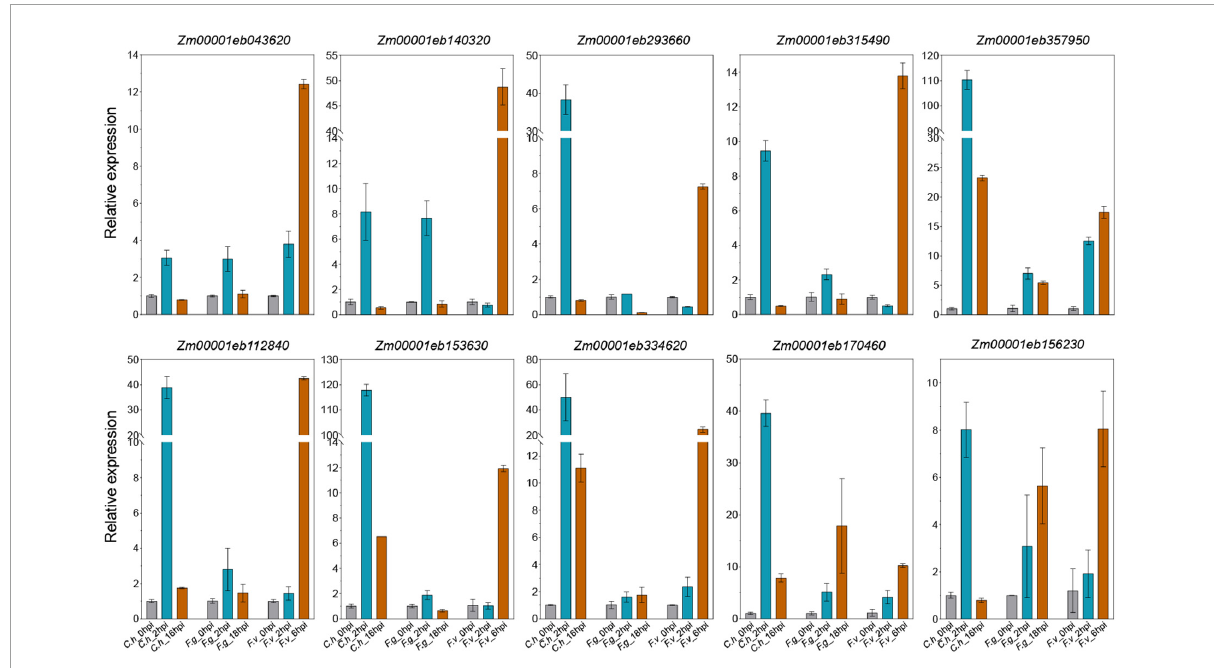
FIGURE7 Quantitative reverse transcription-PCR (qRT-PCR) validation of representative co-DEGs. Data are represented as the mean ± SD from two biological repeats. C.h, Cochliobolus heterostrophus ; F.g, Fusarium graminearum ; F.v, Fusarium verticillioides